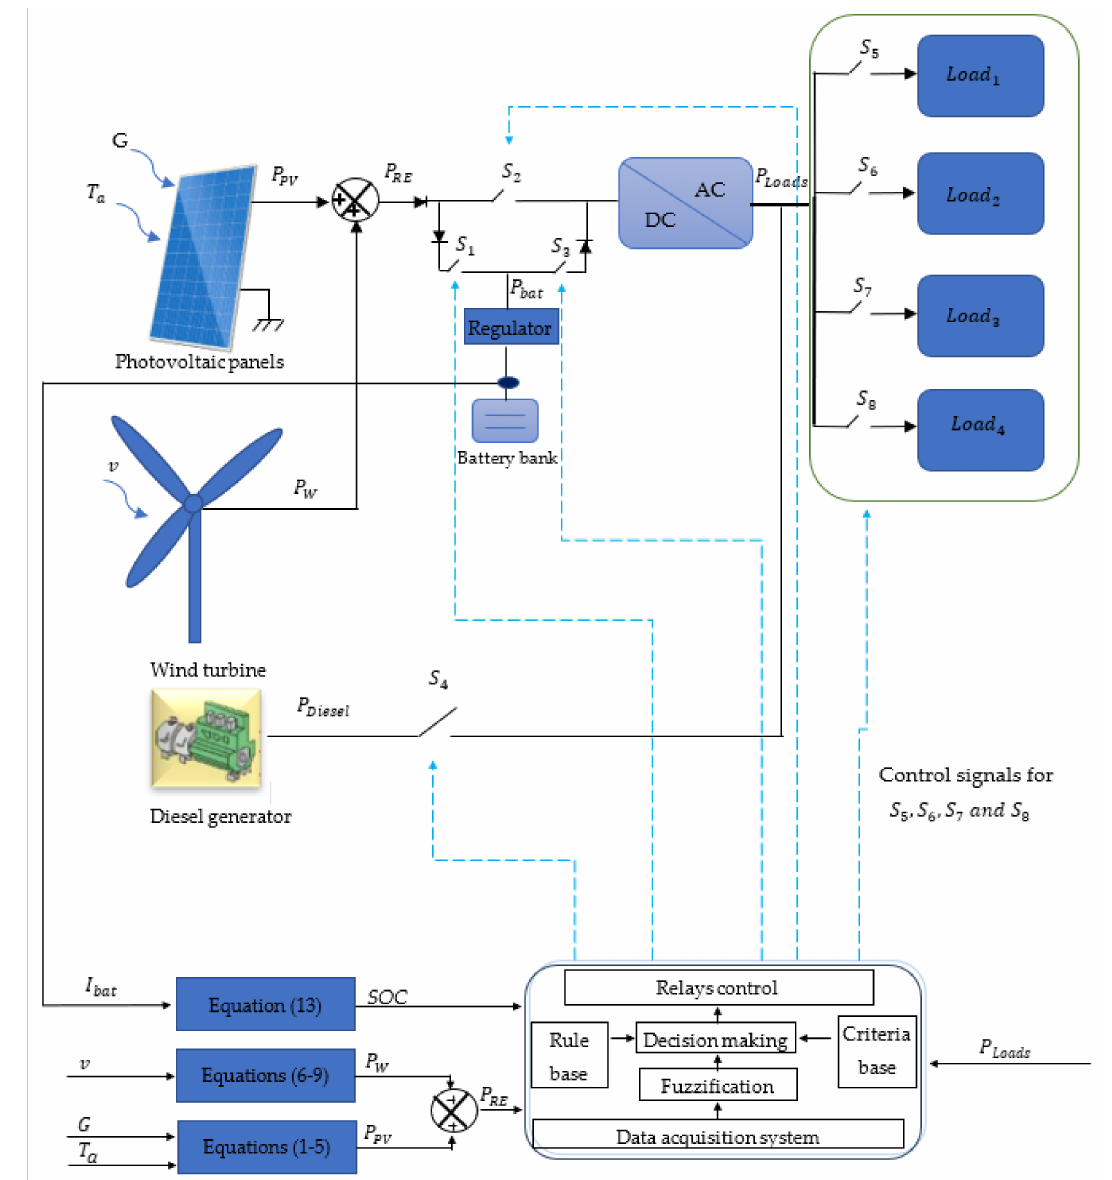
Figure 1. The bloc scheme of the studied hybrid RE